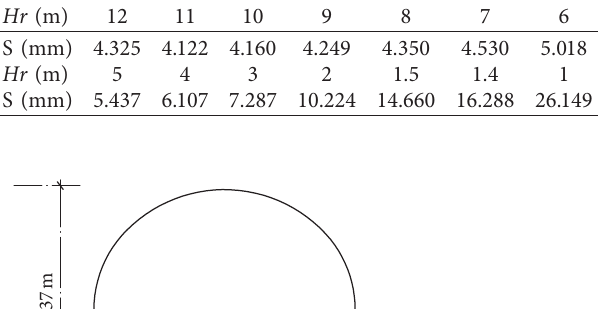
Table 2: Calculation results of the vault vertical displacement.